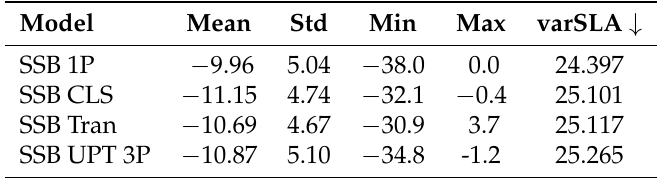
Figure 7. Percentage of scaled sea level anomalies (SLA) variance differences between SLAs computed with SSB_UPT_3P and SSB Tran. Blue squares represent regions with a decrease in SLA variance computed with the proposed SSB model with respect to SSB Tran. Red squares indicate regions where an increase in SLA variance from SSB UPT 3P relative to the SLA variance computed with SSB Tran is observed. Table 4. Summary statistics of the SLA computed with different SSB models for the whole phase A of Jason-1 mission, where conformity between the proposed model SSB_UPT_3P and the established SSB approaches is verified. Last column shows each SSB correction impact on SLA variance reduction. All values in cm with exception to varSLA which is in cm 2